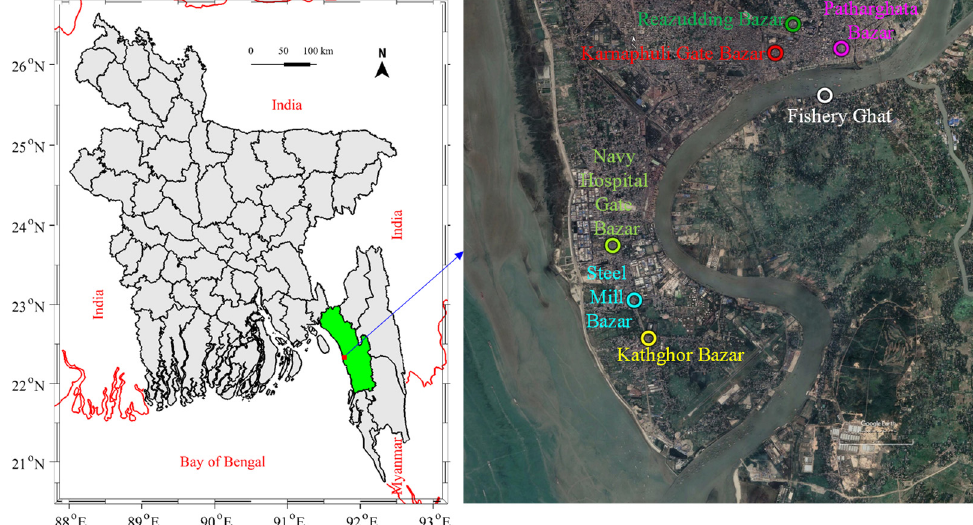
Figure 1. Geographical location of the selected fish markets in Chattogram. Table 1. Characteristics of respondents interviewed in seven selected fish markets.